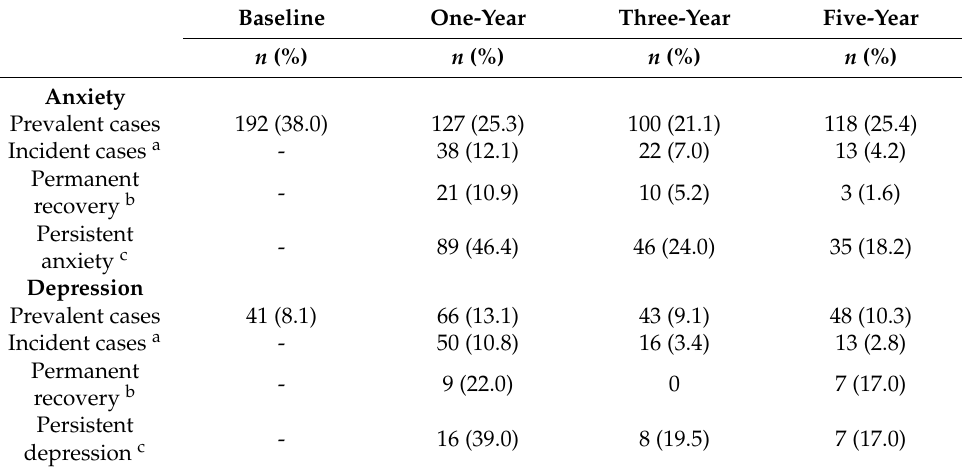
Table 3. Occurrence, persistence, and recovery from clinically significant anxiety and depressive symptoms during the five-year follow-up, assessed with the Hospital Anxiety and Depression Scale